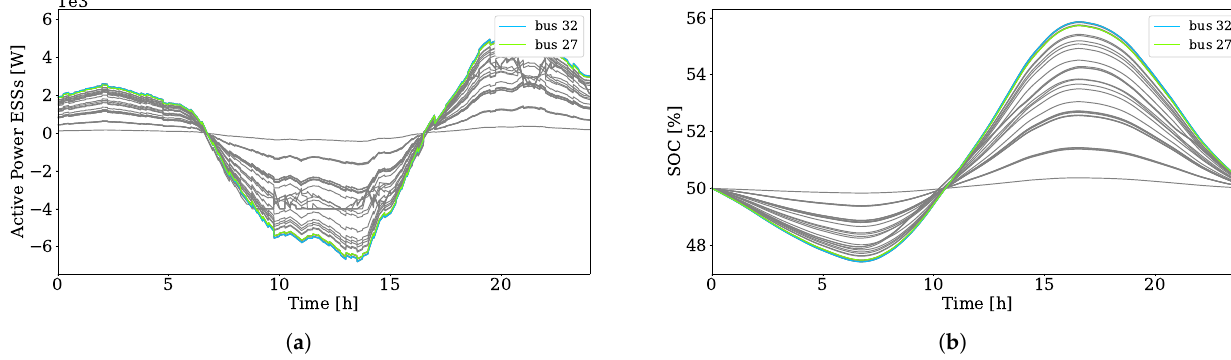
Figure 11. Results of the hierarchical control #3. ( a ) Active power ESS set-points; ( b )